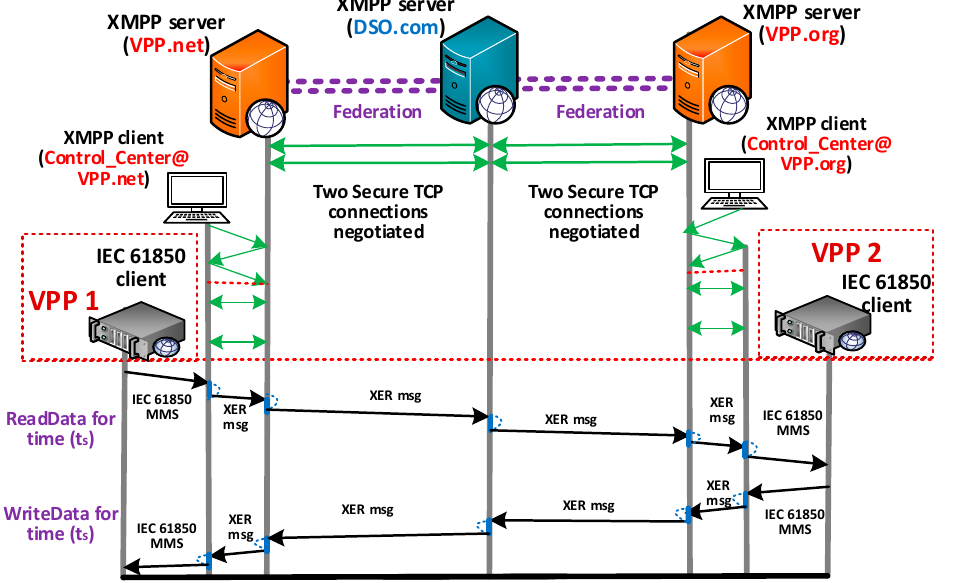
Figure 9. Federation based message flow between VPP_1 and VPP_2 (Case III).